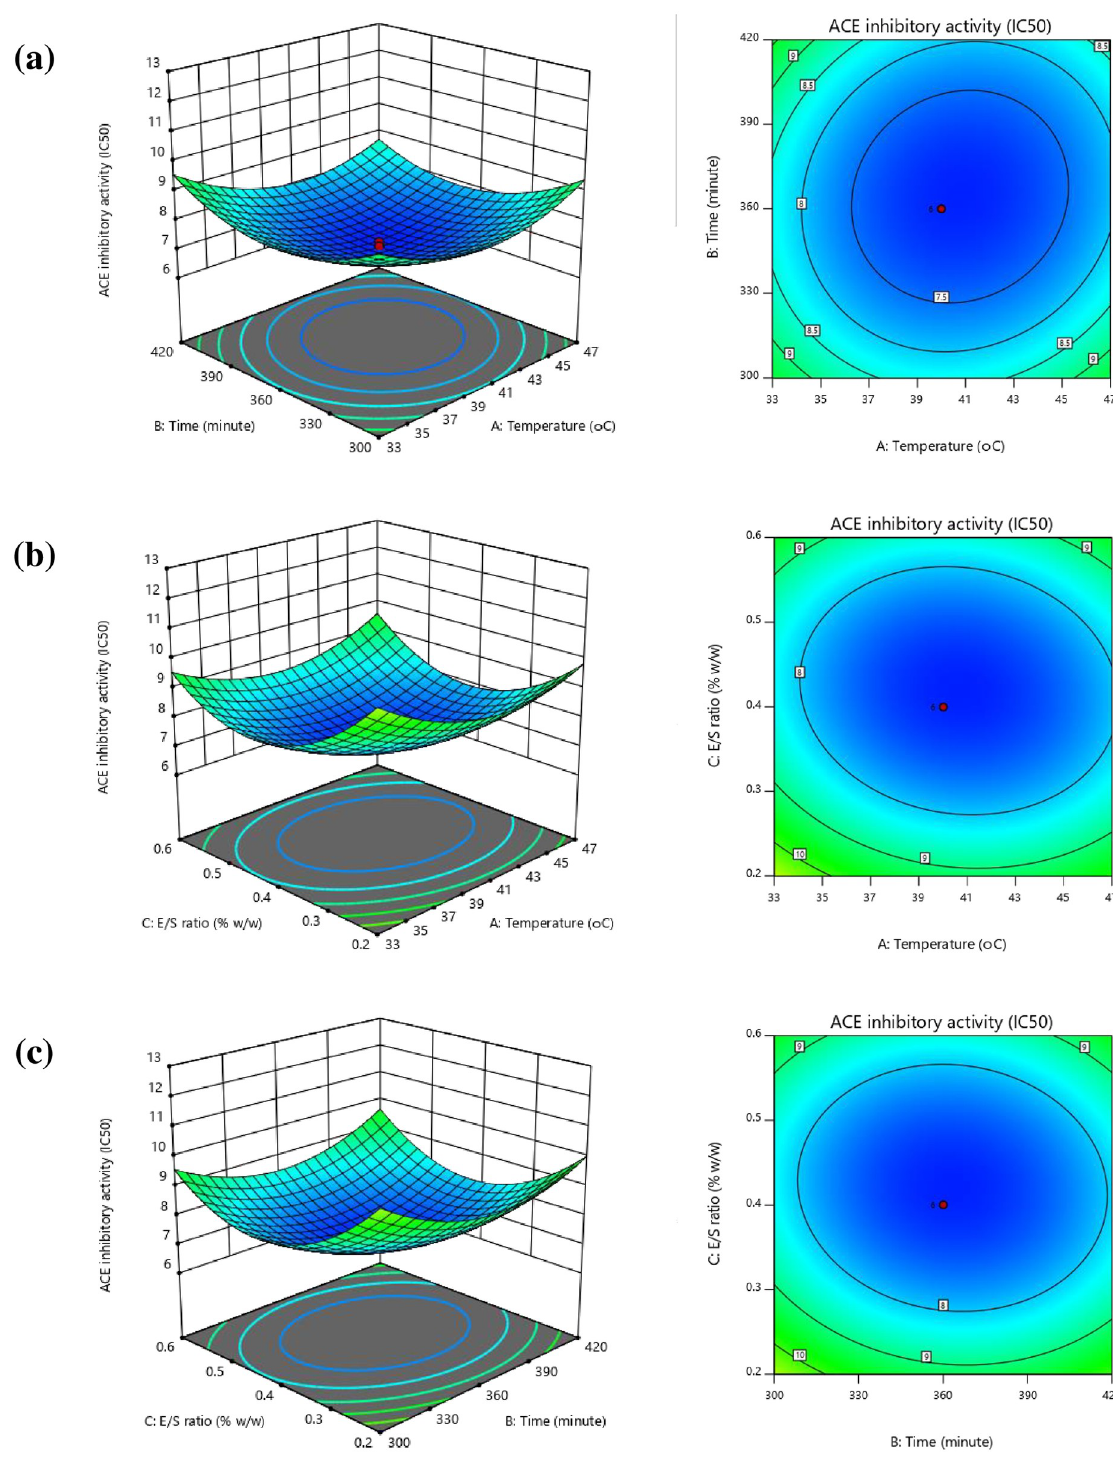
Fig 3. Response surface and contour plots presenting the influence of interactions among independent variables upon ACE-inhibitory activity (IC 50 ; μ g/mL). (a) influence of temperature and time, (b) influence of temperature, and E/S ratio, and (c) influence of time and E/S ratio.